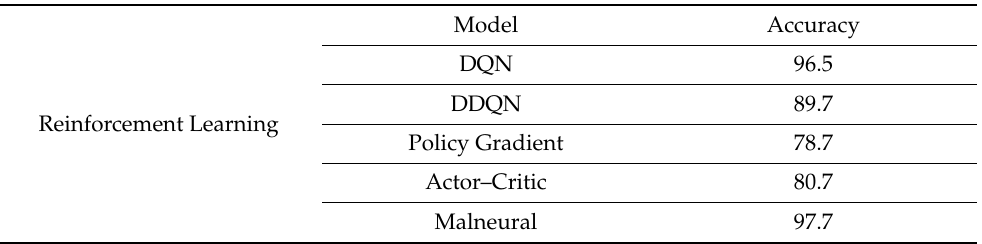
Table 9. Accuracy calculation for monkeypox disease detection results using the reinforcement learning approach.